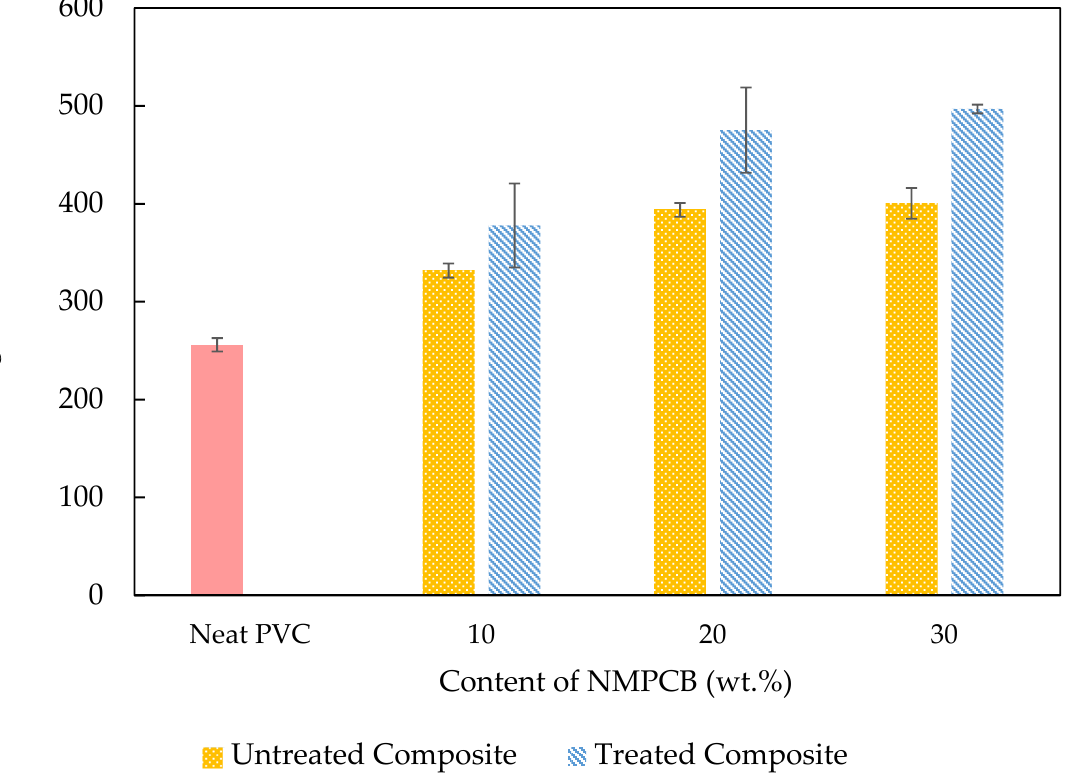
Figure 5. Young’s Modulus of untreated and treated NMPCB/PVC composites.